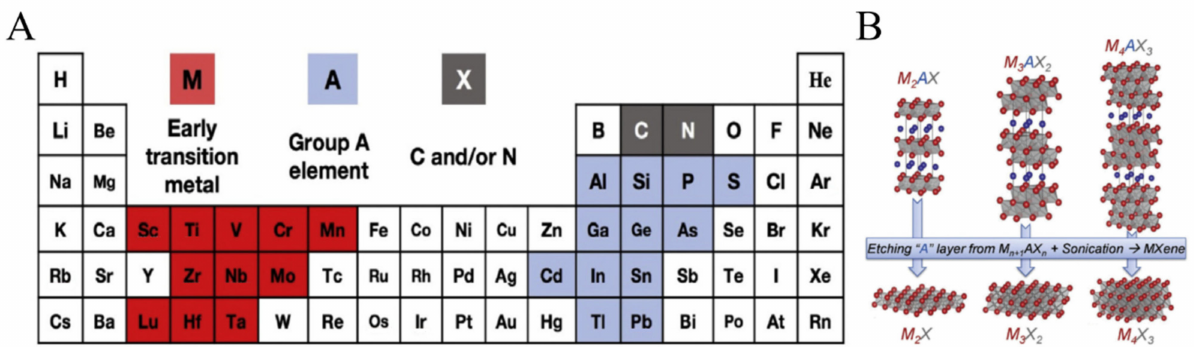
Figure 1. ( A ) Elements involved in the formation of MAX phase and ( B ) MXenes derived from different MAX phases. (reproduced with permission [4]. Copyright 2019,